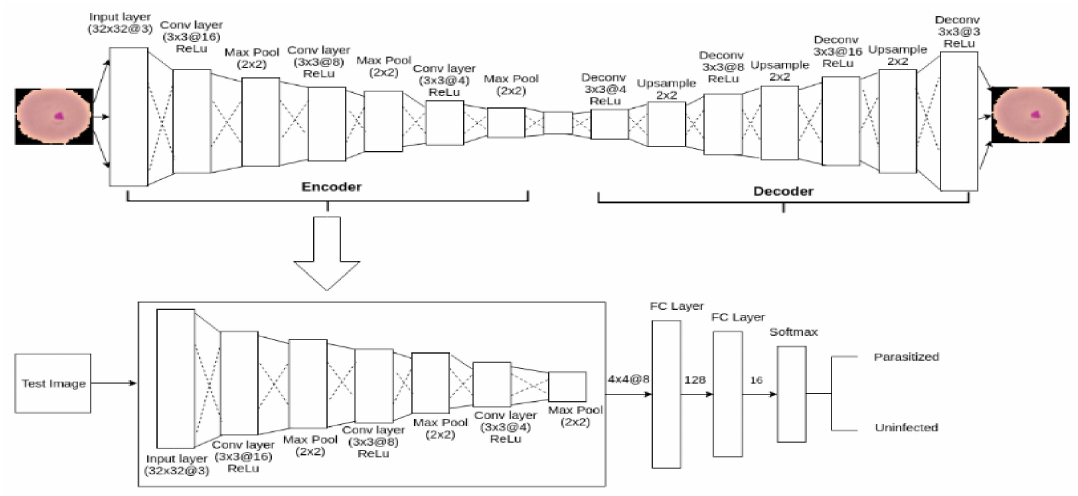
Figure 3. The outline of autoencoder